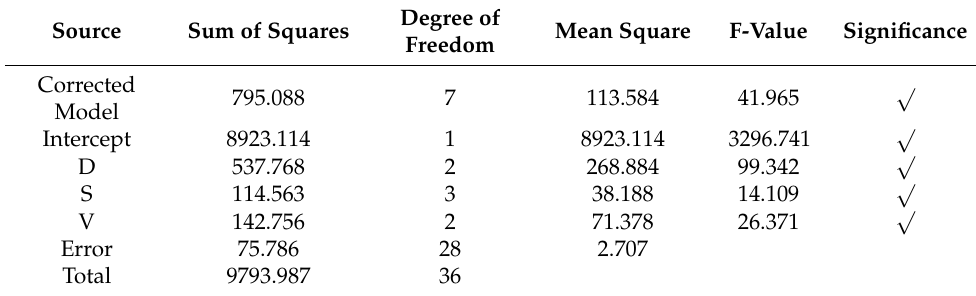
Figure 1. Separating Hopkinson pressure bar system. Table 4. Significance analysis of main factors.